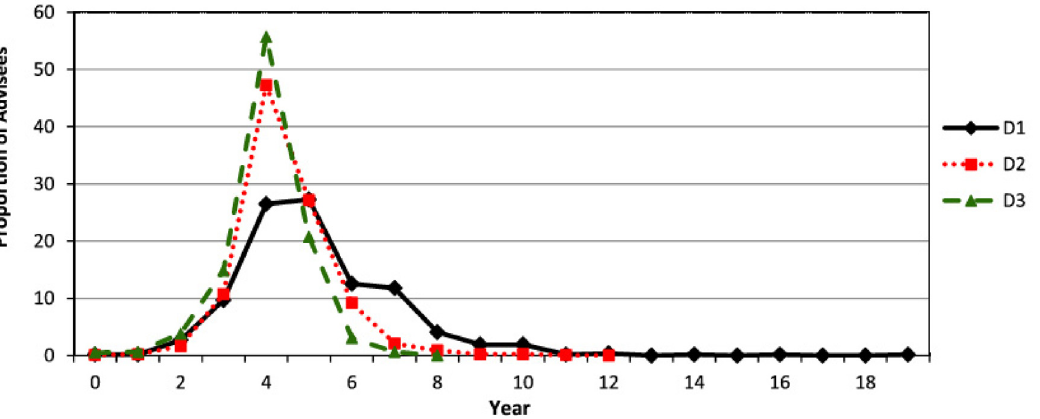
Fig 1. Frequency distribution of the number of years to obtain the PhD degree ( T C 2000 and D3 = 2001 –